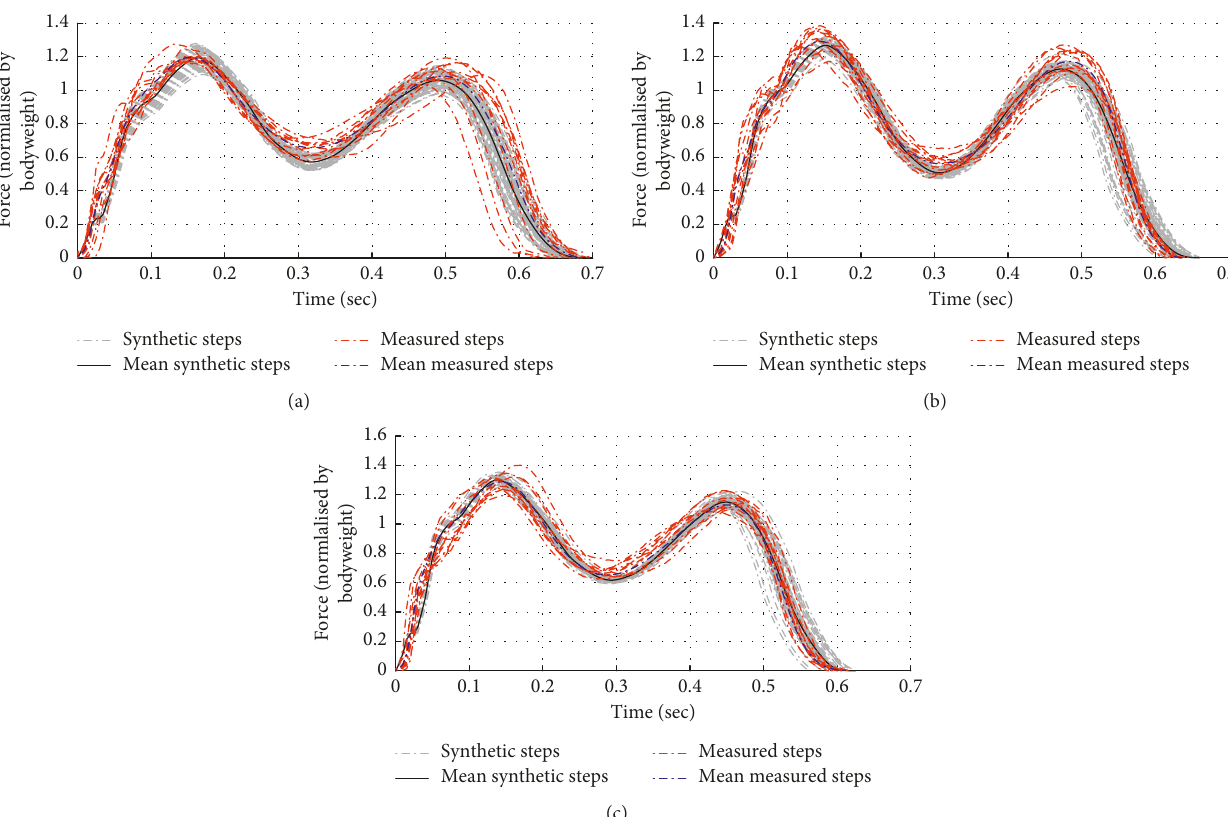
Figure 10: Comparison of synthetic walking steps against measured steps. (a) Pacing rate of 1.8Hz, (b) pacing rate of 2.0Hz, and (c) pacing rate of 2.2 Hz.